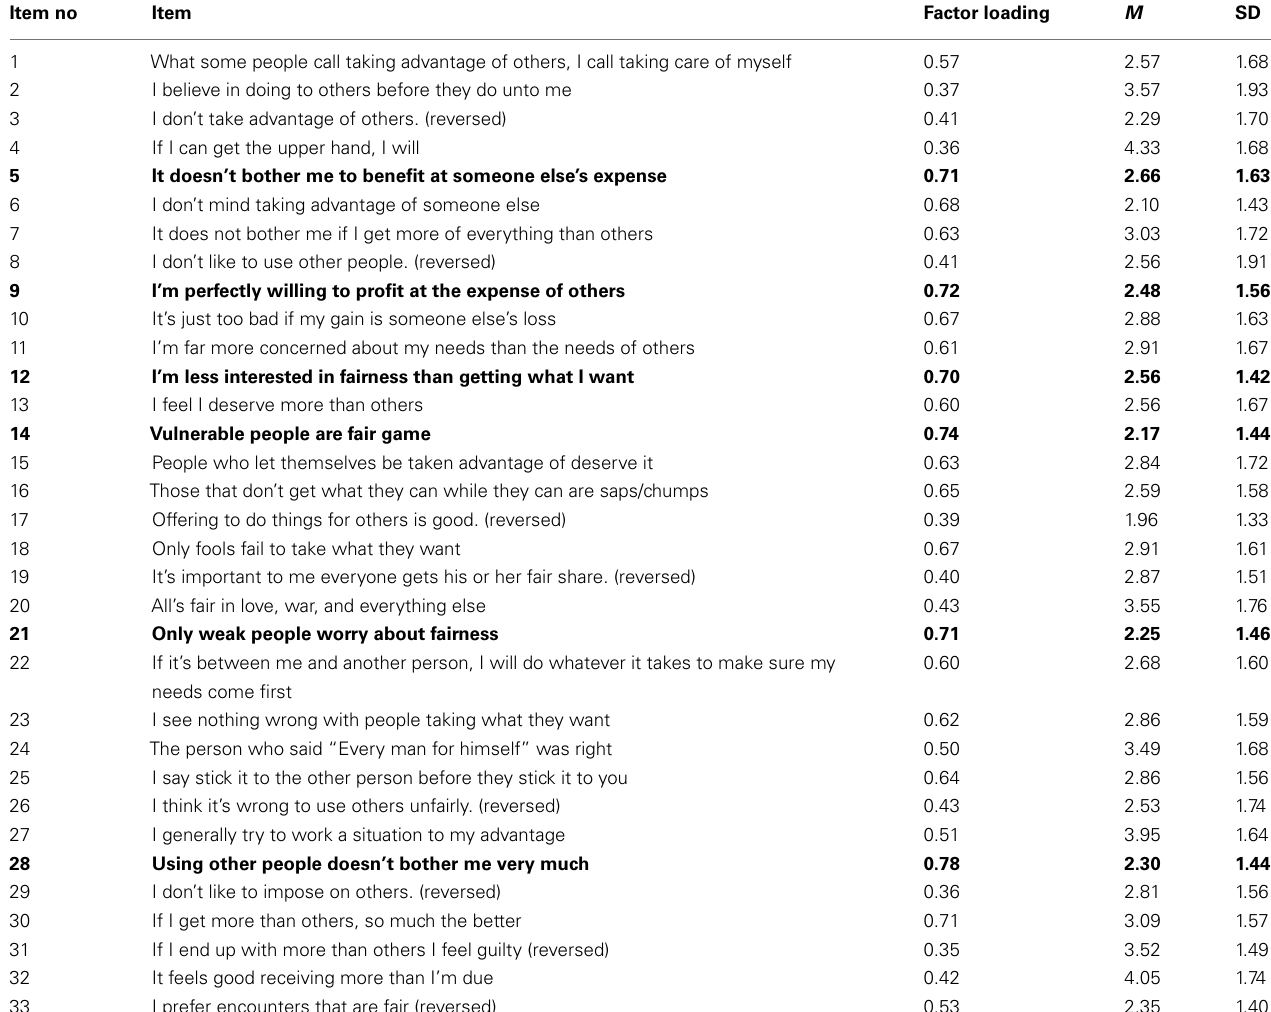
Table 2 | Factor analysis and item means (SD) of the Interpersonal Exploitativeness Scale (Study 1).